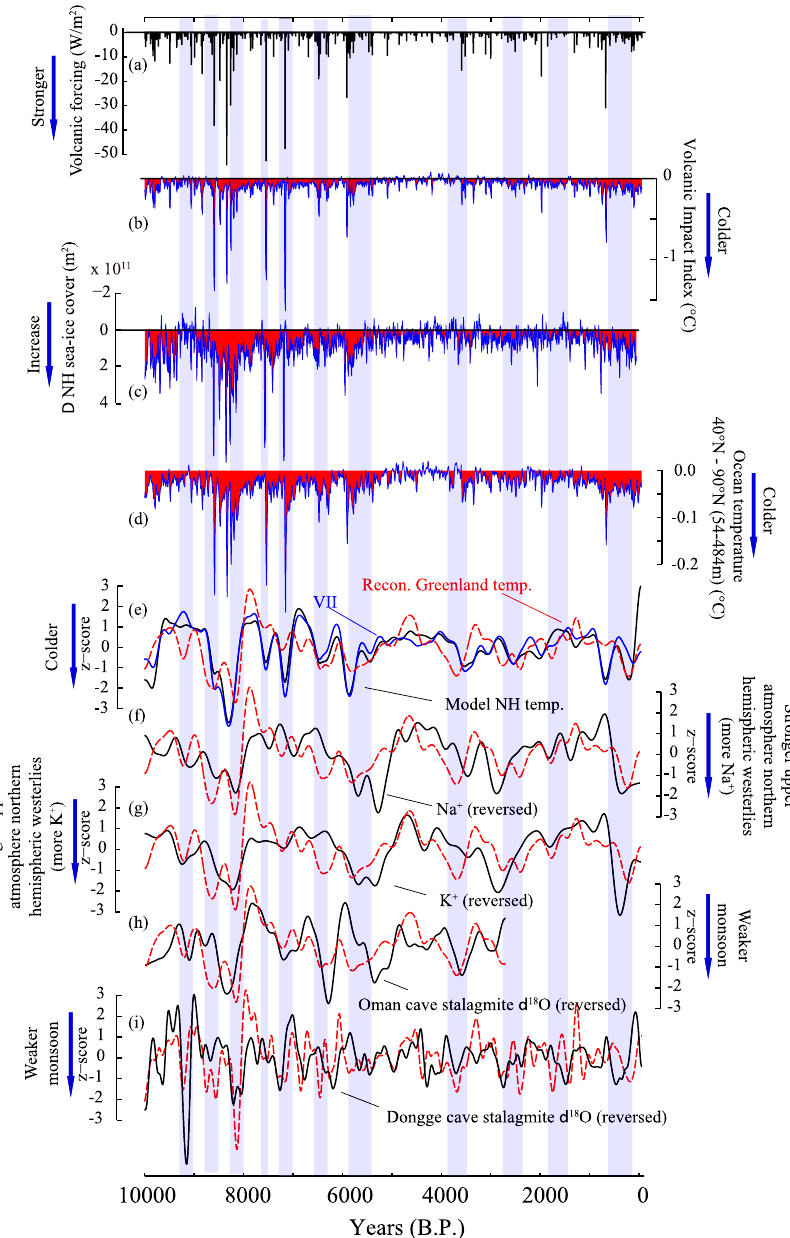
Figure 4. Centennial to millennial-scale volcanic impacts on climate over the past 10,000 years. ( a ) Raw volcanic forcing, ( b ) Volcanic Impact Index (VII), the difference between two curves in Fig. 3c. ( c ) Δ NH sea-ice cover (y-axis is reversed) is calculated as differences between experiments with full forcing and without volcanic forcing (ensemble means) in 21-year RMs, ( d ) as in (c ) but for ocean temperature (54–484 m) in 40°N–90°N. Red dotted lines in ( e – i ) show bandpass-filtered Greenland temperatures, which are compared to ( e ) modeled NH average temperatures (Methods), and VII, ( f ) Na + ion in GISP2 (a proxy for atmospheric circulation) 22 , ( g ) K + ion in GISP2 (proxy for atmospheric circulation) 22 , ( h ) Oman cave stalagmite δ 18 O 1 , ( i ) Dongge cave stalagmite δ 18 O 64,65 . Different bandpass filters were applied for ( e , f , g , h ) and ( i ) with 400–4000 year bands and 200–2000 year bands after linear detrending, respectively (Methods). Red areas in ( b – d ) indicate periods under relatively strong volcanic influence. Blue shades are the Greenland cold episodes as in Fig.